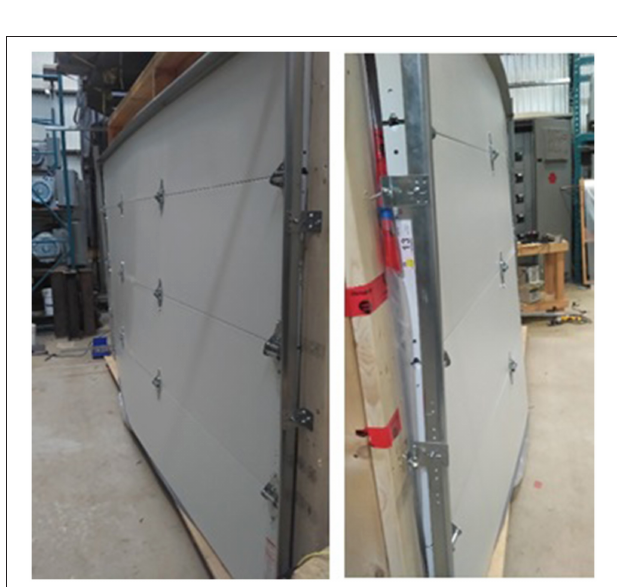
FIGURE 7 | Photographs of hardware pull-out for Product 4 (triple layer, 26- and 25-gauge steel door with U-bar reinforcement) just prior to failure.